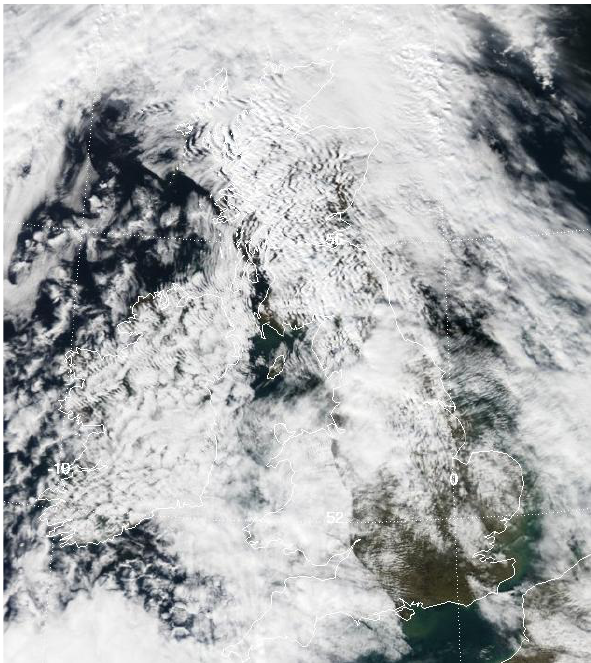
Fig. 1. The MODIS visible satellite image for the UK at 13:05 UTC on 27 February